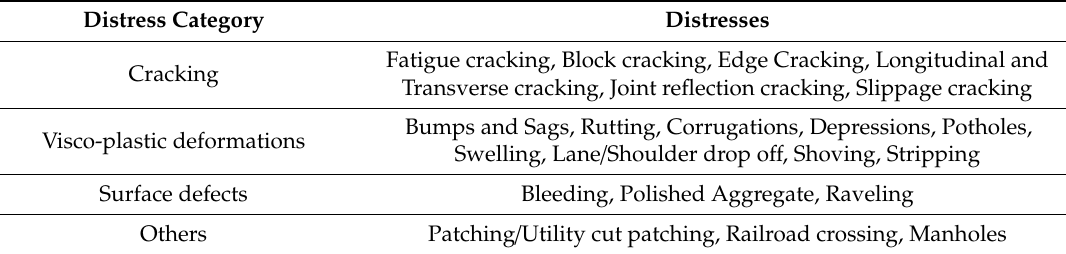
Table 1. Generalized pavement distress categories.